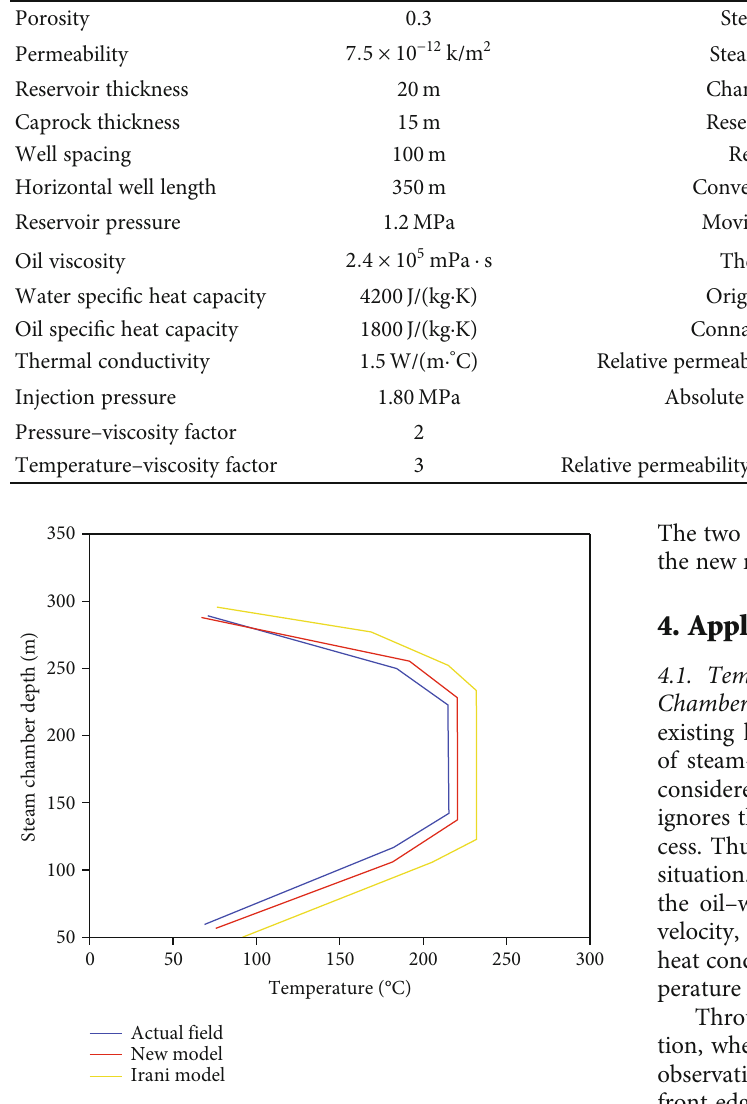
Figure 5: Schematic of temperature change curves of di ff erent steam